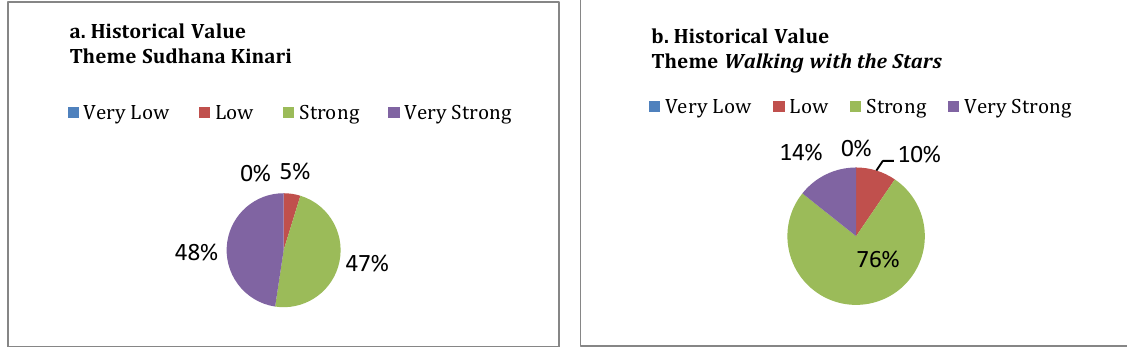
Fig. 2 Historical Value Theme 1; a Sudhana Kinari , b Walking with the Stars